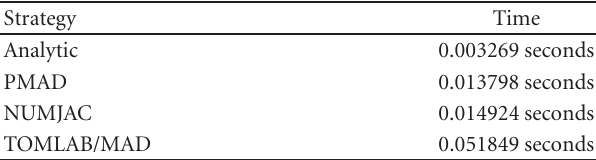
Table 1: Computation times for various di ff erentiation